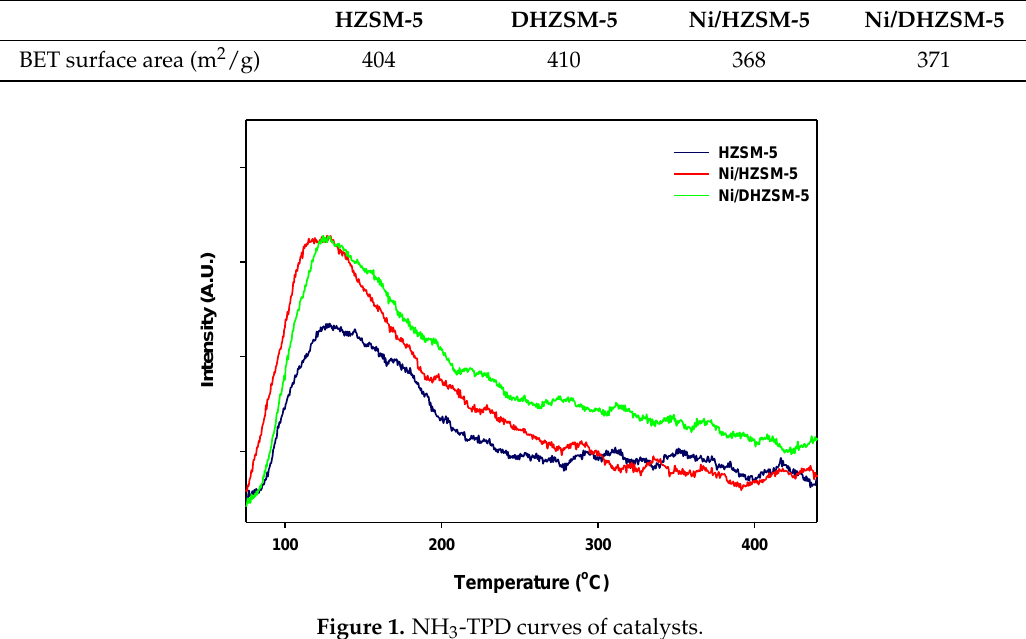
Table 2. Properties of catalysts.